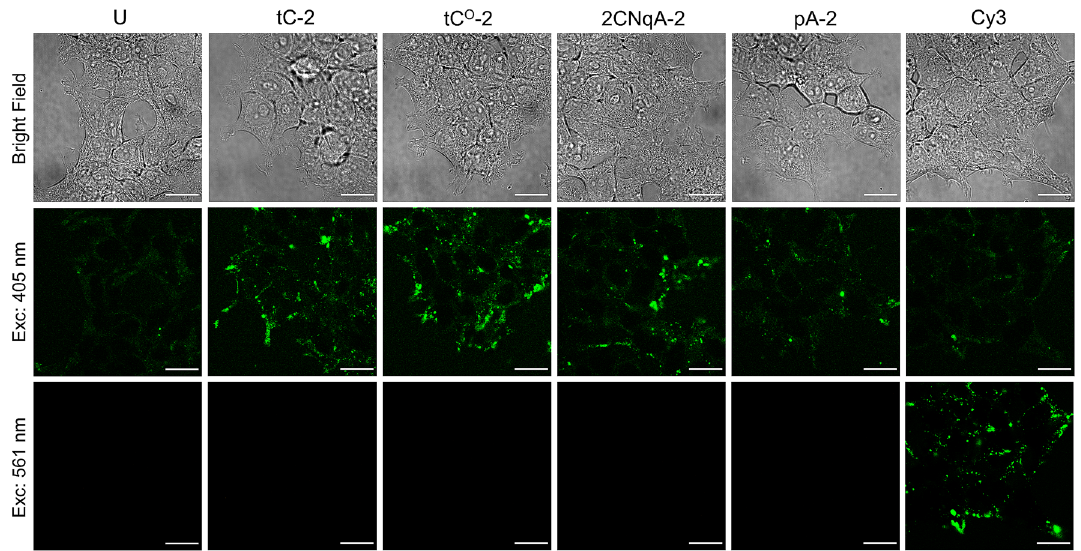
Figure 5. Confocal microscopy images of live HEK 293 T cells continuously exposed to unformulated gapmers (3 µM) for 24 h. Samples were excited at 405 nm (emission: 407–700 nm) for FBA detection and at 561 nm (emission: 563–700 nm) for Cy3 detection. Scale bars are 20 µm.